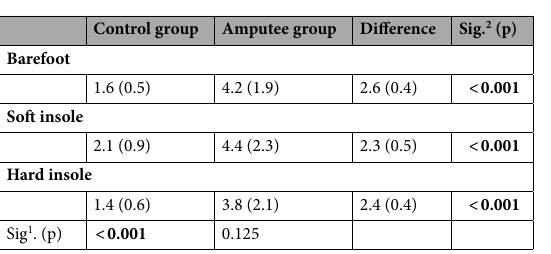
Table 6. Comparison of lateral velocity between the different insoles in each experimental group. Significant values are in [bold]. Mean (standard deviation). 1 Friedman Test. 2 Mann–Whitney Test. Lateral velocity (mm/